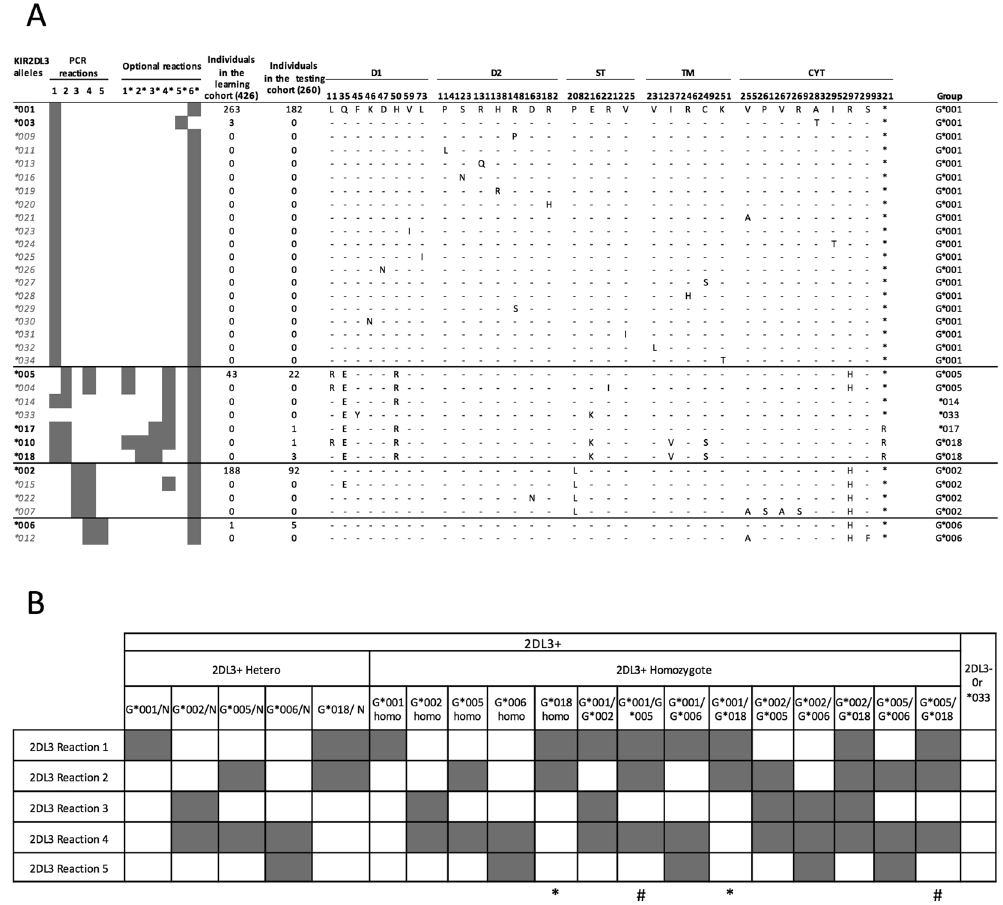
Figure 3. KIR2DL3 allele typing method. ( A ) Alignment of the amino acid sequences of the 34 known KIR2DL3 allelic variants. A dash indicates identity with the consensus KIR2DL3 * 001 , an ( * ) indicates a stop codon. Structural domains are indicated: Ig-like domains (D1 and D2), stem domain (ST), transmembrane domain (TM), and cytoplasmic domain (CYT). Five PCR reactions separate the four subgroups identified by phylogenetic analysis. Six additional PCR reactions separate alleles within subgroups. Frequencies of the alleles present in the learning cohort of 426 individuals and in the testing cohort of 260 individuals are indicated. The group identification for each allele is indicated. The alleles tested by PCR are in bold black font, and the non-tested alleles are in gray italics. ( C ) KIR2DL3 PCR interpretation guide. PCR profiles marked by * or # are similar and require a higher resolution of genotyping using supplemental